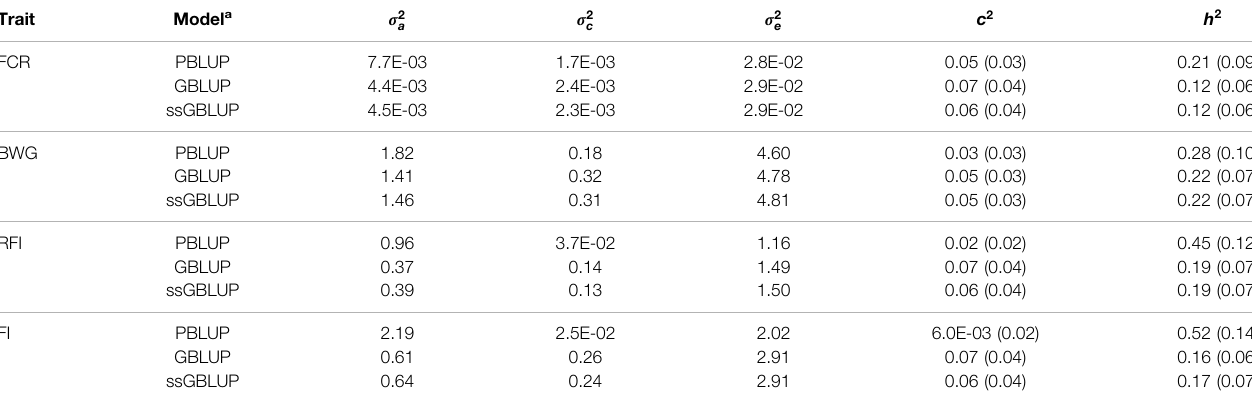
TABLE2| Estimatedadditivegenetic( σ 2 a ),common( σ 2 c ),andresidual( σ 2 e )varianceparameters,commonenvironmentaleffects(c 2 )andheritabilities(h 2 )forfeedconversion ratio (FCR), body weight gain (BWG), residual feed intake (RFI) and feed intake (FI). Standard error is shown inside brackets. Trait